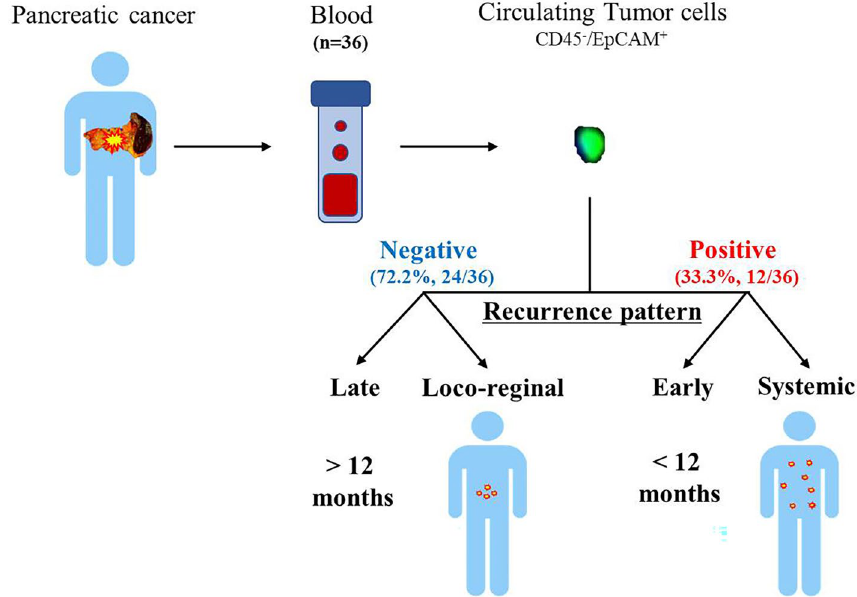
Figure 2. Postoperative recurrence pattern according to the presence of CTC in the blood of patients with pancreatic cancer. This graphic abstract focuses on the contents of Table 3. When CTC is detected before surgery, there is a tendency to have more early and systemic recurrence